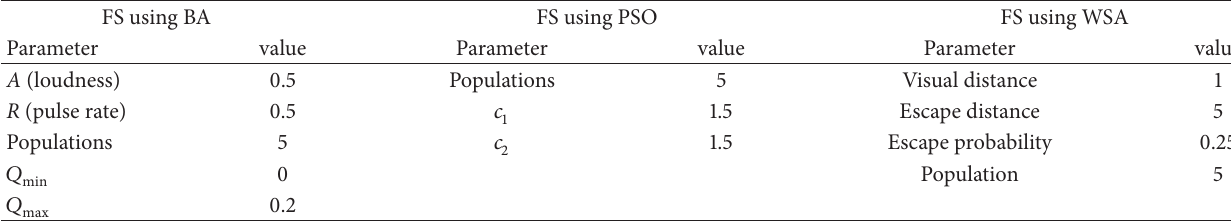
Table 4: Parameter settings for metaheuristic methods.